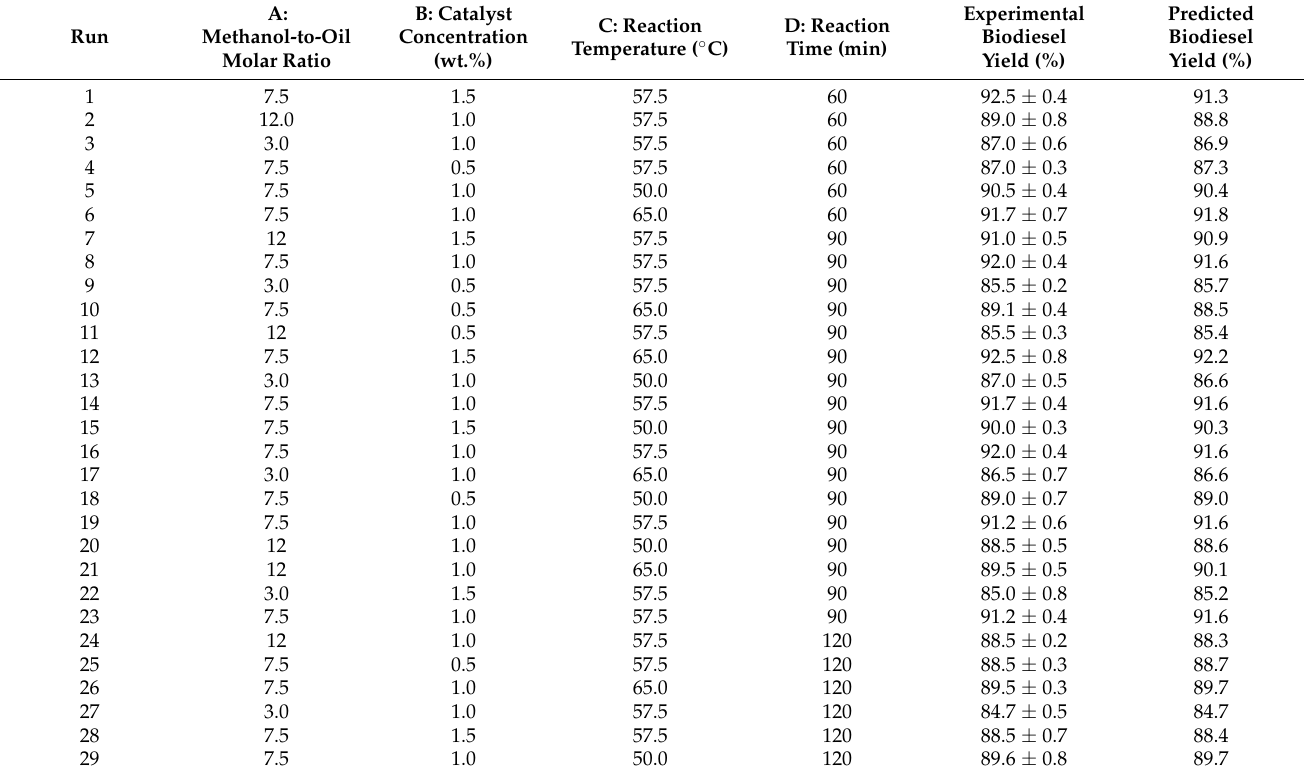
Table 3. BBD matrix-based experimental input–output data collection of the transesterification